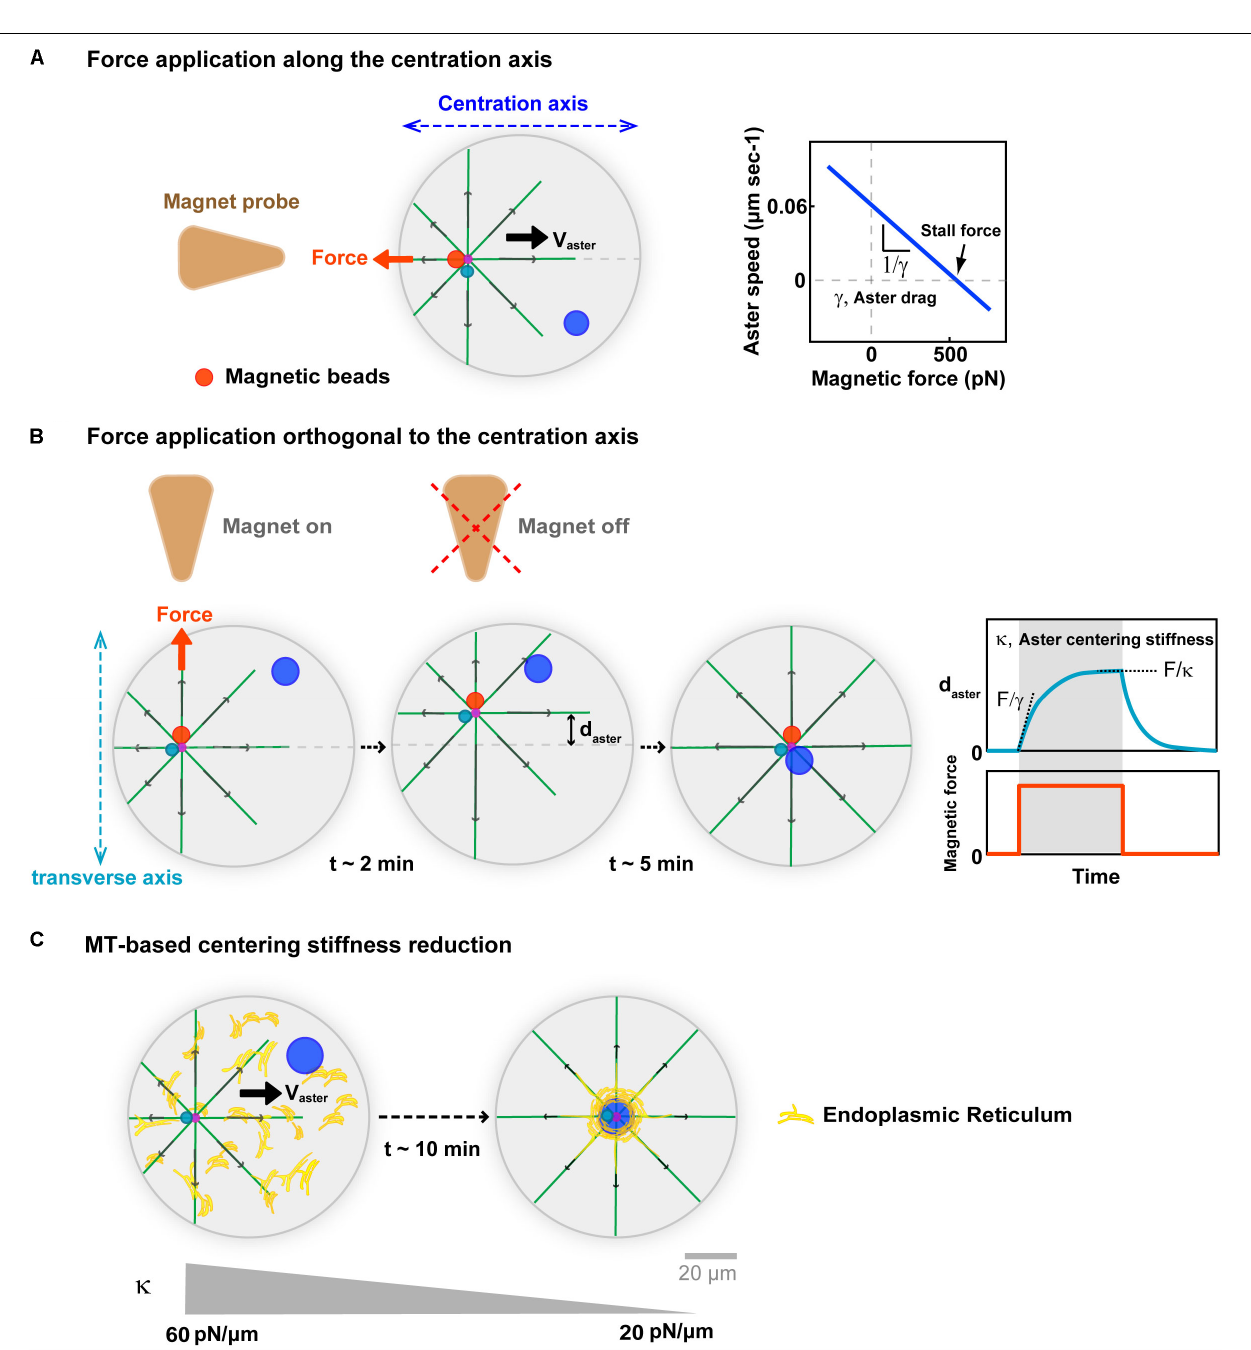
FIGURE 3 | Implications of MT cytoplasmic forces for aster centration. (A) External calibrated magnetic forces applied with magnetic tweezers on the aster center, through minus-end accumulated beads in sea urchin embryos. Forces applied along the centering axis serve to derive force-velocity relationships for centering asters. This relationships is mostly linear supporting a motion limited by viscous interactions, with the slope allowing to compute an effective drag. The intersection of the line with the x-axis yields estimates of the aster endogenous force of ∼ 600 pN. Modified according to Tanimoto et al. (2018). (B) Forces applied orthogonal to the centering axis serve to characterize MT-based visco-elastic forces stabilizing the centered position of the aster in the transverse axis during centration. Blue curve: Typical experimental displacement-time curve, allowing to compute visco-elastic parameters of MT-based centering system. Upon force application, the aster moves toward the magnet until reaching an equilibrium plateau, and recoils back to the center after releasing the force, behaving as a spring. Computation of the centering stiffness and the drag from the plateau and the slope of the curve. Modified from Tanimoto et al. (2018). (C) Successive force measurements showed that aster centering stiffness becomes reduced during aster centration (Salle et al., 2019). Proposed model for how cytoplasmic forces may become less efficient during centration, and yield to this stiffness reduction: As the aster centers, dynein drags endomembranes to the cell center, depleting the rest of the cytoplasm, and thereby rendering cytoplasm force exertion less efficient. Modified from Terasaki and Jaffe (1991) and Salle et al. (2019).